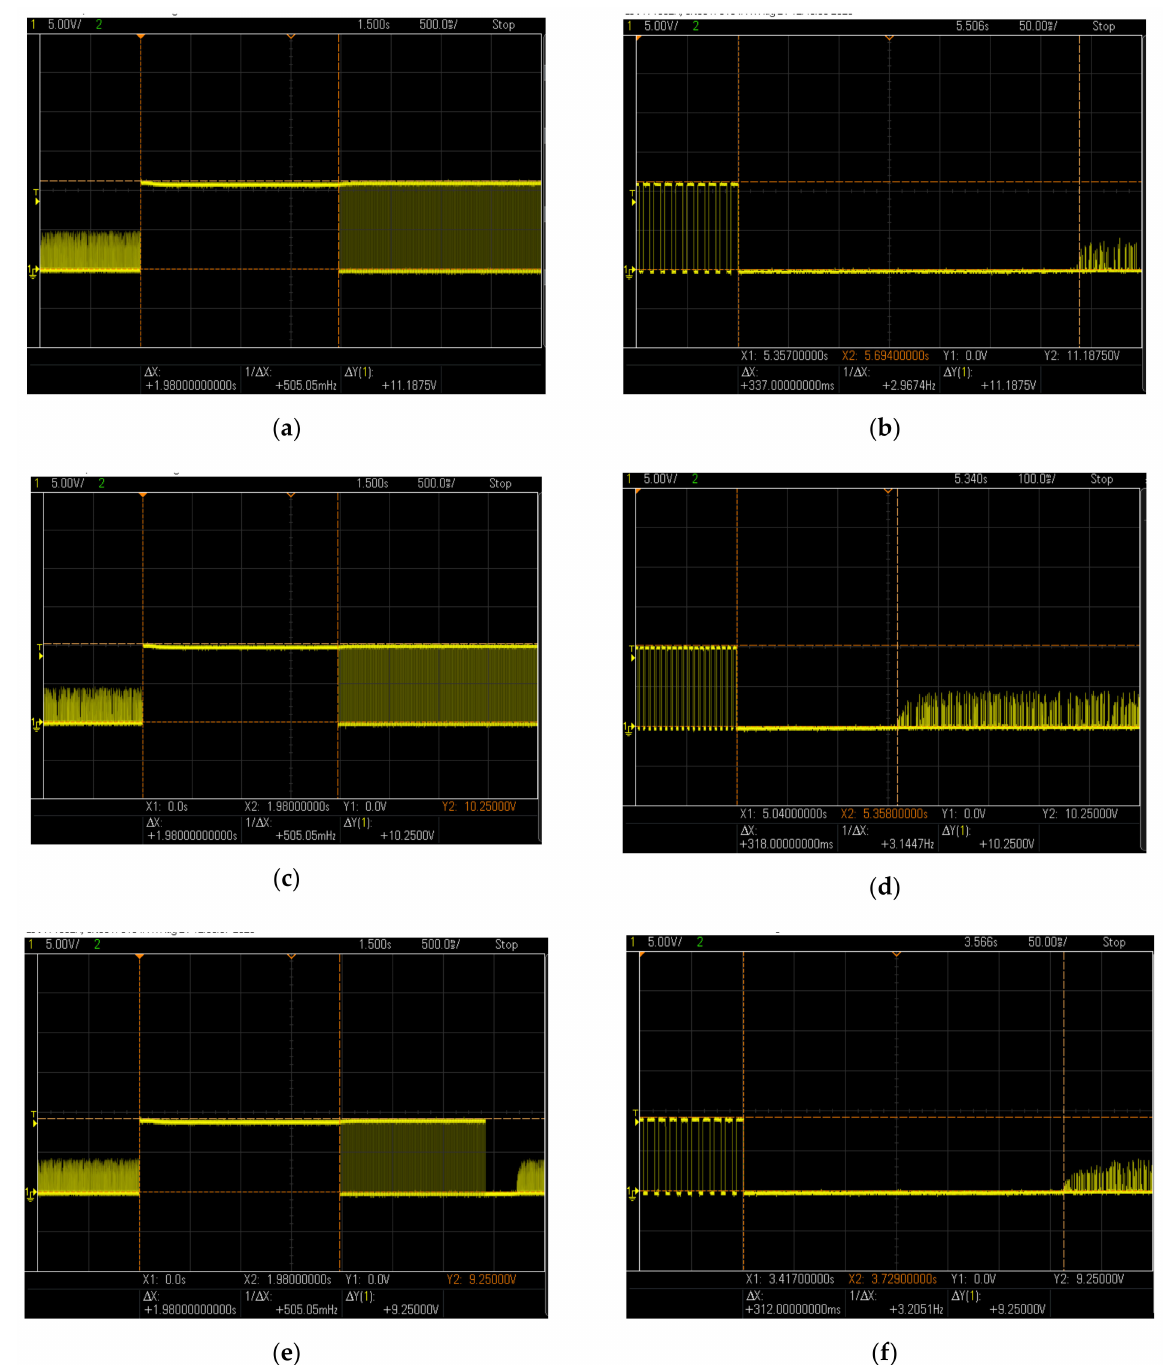
Figure 7. Switch-on time and delay of the Pulse Width Modulation (PWM) and full PWM signal for the function of sliding up and down the legs: ( a ) supply voltage of 12 V for switching on time ∆ X = 1.98 s, ( b ) supply voltage of 12 V for delay time. ( c ) Supply voltage of 11 V for switching on time ∆ X = 1.98 s, ( d ) supply voltage of 11 V for delay time, ( e ) supply voltage of 10 V for start-up time ∆ X = 1.98 s, and ( f ) supply voltage of 10 V for delay